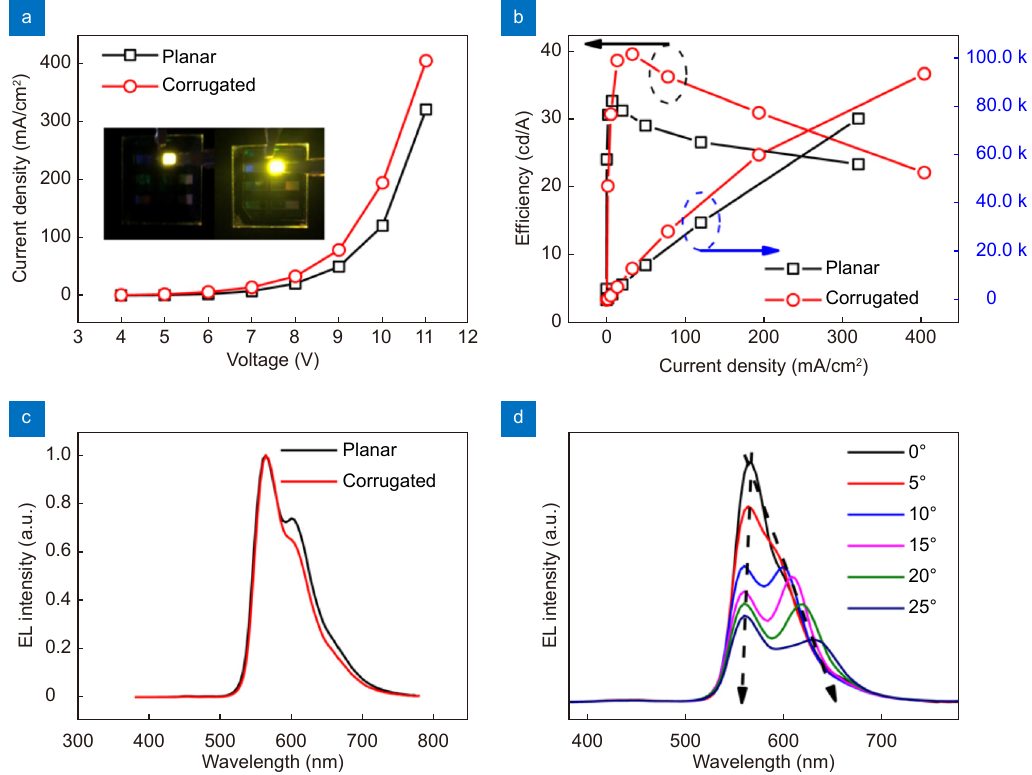
Fig. 5 | EL performance of OLEDs based on Ag-Al alloy cathodes with and without corrugations . ( a ) Current density-voltage and ( b ) effi- ciency-current density-luminance features, and ( c ) normalized EL spectra of corrugated and planar OLEDs. ( d ) The angle-dependent EL spectra of the corrugated OLEDs under TM polarization. The inset in (a) shows the photos of corrugated OLEDs and planar OLEDs operated at 6